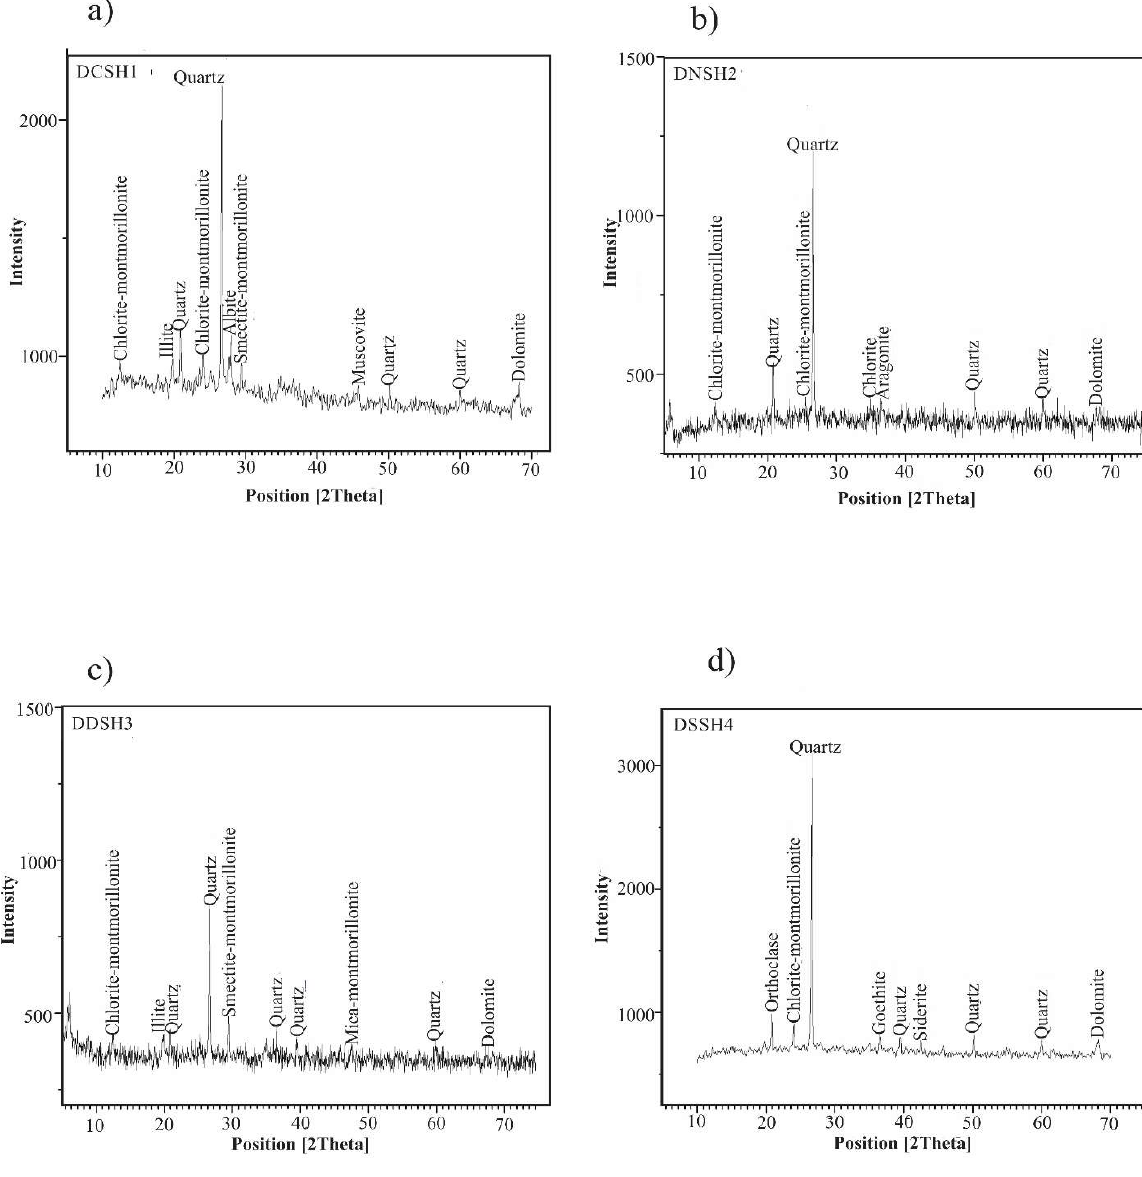
Figure 11. Graphs showing the powder X-ray diffraction pattern of Siwalik Group shales. ( a ) Chinji Formation, ( b ) Nagri Formation, ( c ) Dhok Pathan Formation, and ( d ) Soan Formation.